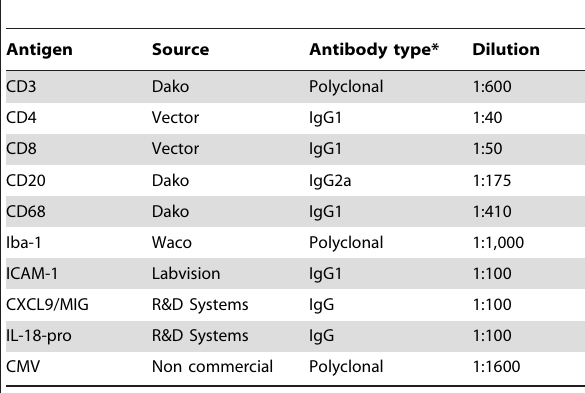
Table 2. Antibodies used for